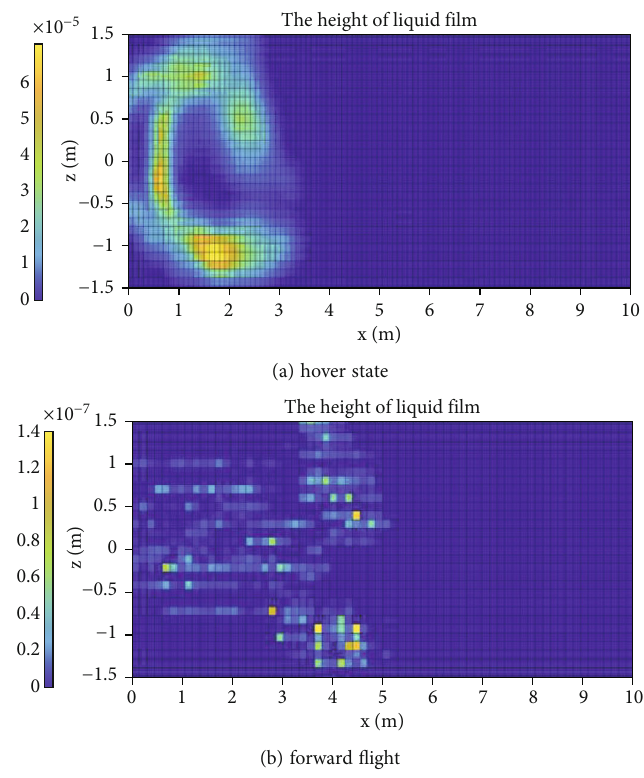
Figure 8: The height of deposited liquid fi lm on the ground when velocity is 1